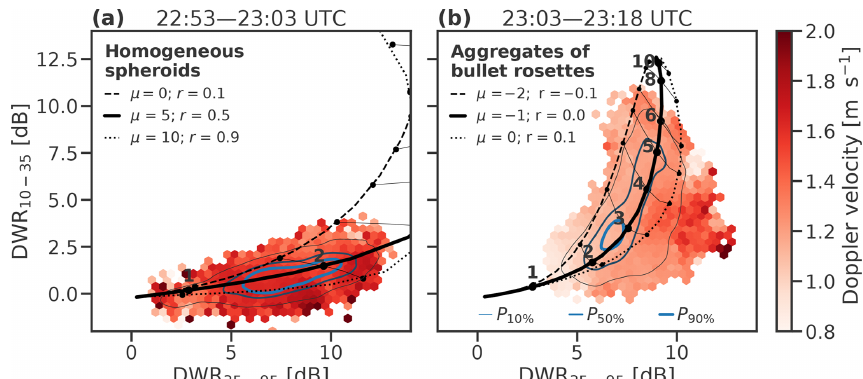
Figure 7. Triple-frequency radar measurements below 2km above ground level in the (a) rimed and (b) unrimed snow regimes of the 21 February 2014 case at Hyytiälä, Finland. Triple-frequency radar measurements are coloured by the corresponding mean Doppler velocity, and frequency of occurrence is indicated with blue contours at the 10th, 50th and 90th percentiles. Overlaid are triple-frequency radar signatures for (a) homogeneous spheroids and (b) fractal particles (aggregates of bullet rosettes; Table 1) with a range of values of PSD shape parameters and density factors that encompass the most frequent triple-frequency radar measurements. Increments of median volume diameter are labelled in